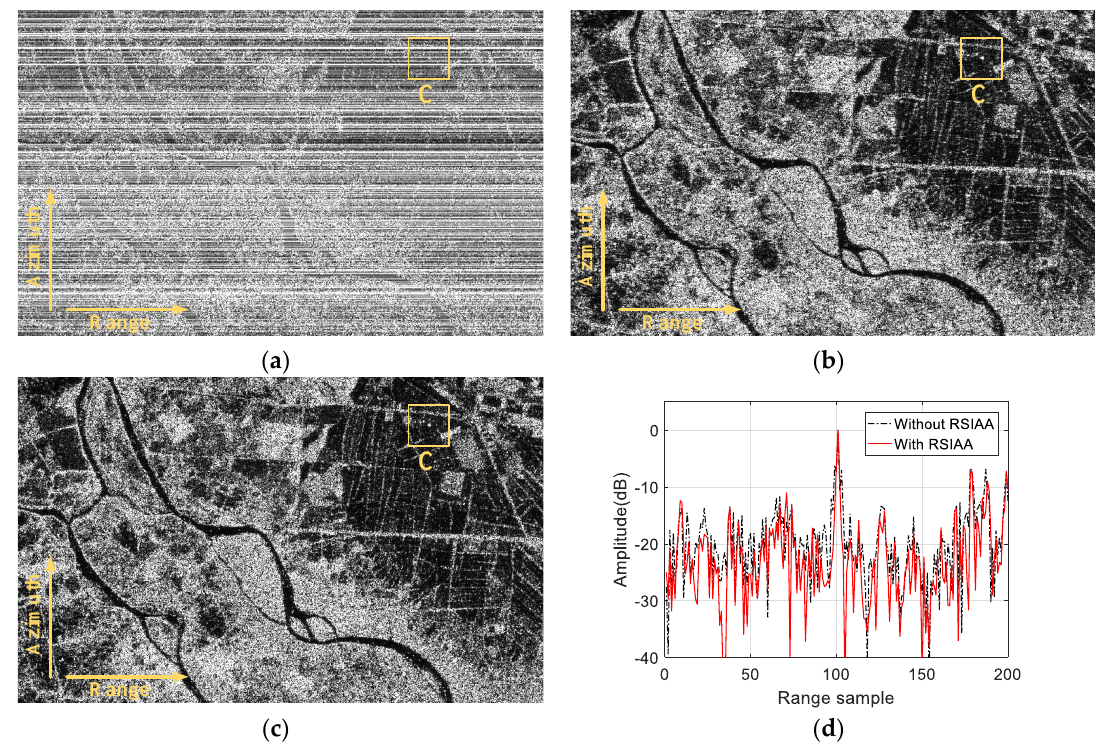
Figure 16. Imaging results of the first set of Sentinel-1 SAR data. ( a ) The SAR image with RFI; ( b ) the SAR image without the RSIAA; ( c ) the SAR image with the RSIAA; ( d ) range profiles of the target in area C.